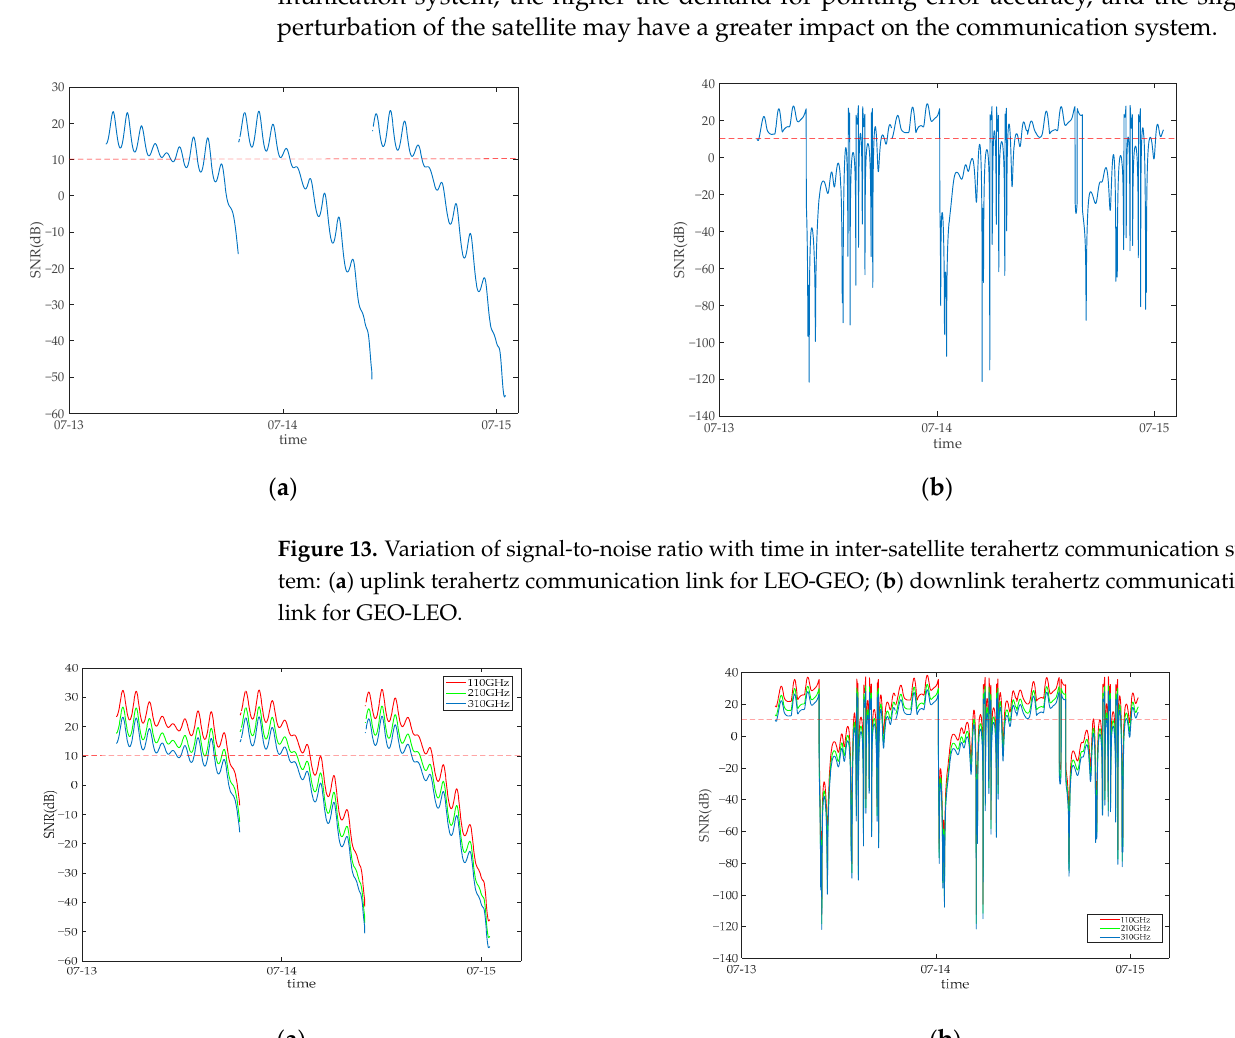
Figure 14. Variation of signal-to-noise ratio with time at different communication frequencies in inter-satellite terahertz communication system: ( a ) uplink terahertz communication link for LEO-GEO; ( b ) downlink terahertz communication link for GEO-LEO.